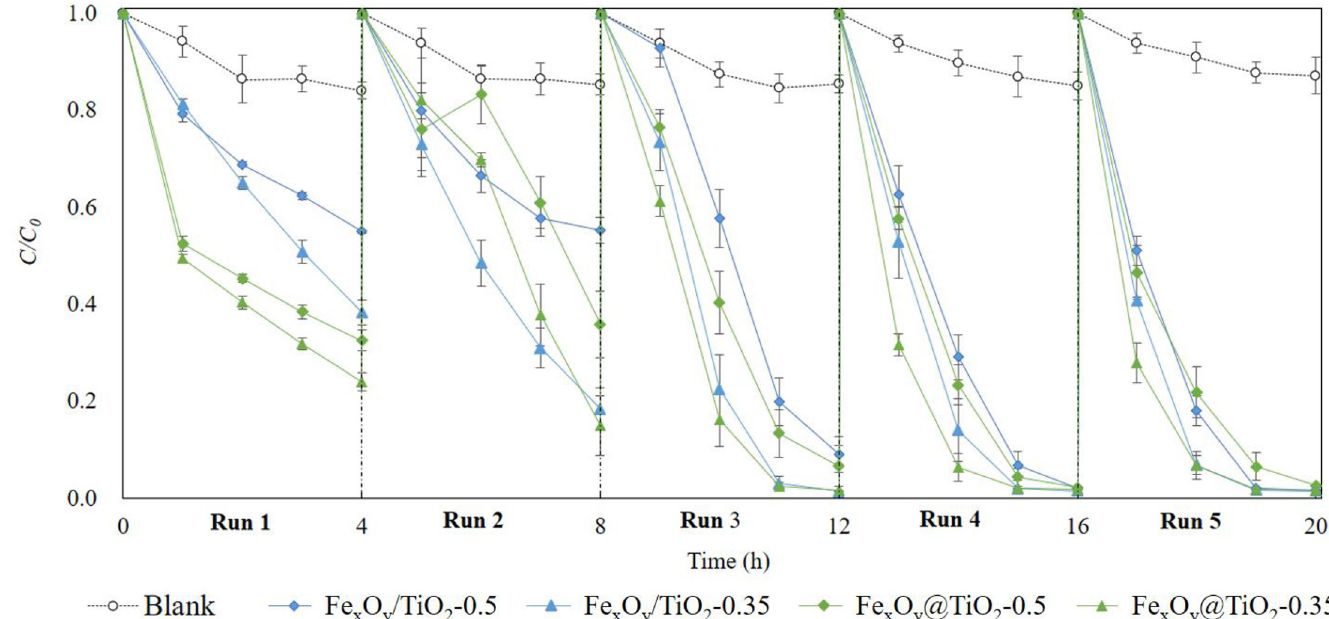
Fig 6. R6G degradation performance after reusing magnetic-TiO 2 -nanocomposites 5 times. Dotted lines represent R6G concentration dynamics in blank treatment without magnetic-TiO 2 -nanocomposites and solid lines represent R6G photodegradation dynamics under UV-irradiation with magnetic-TiO 2 -nanocomposites. Experimental conditions: UV-irradiation, 253 nm (20 W); initial magnetic TiO 2 nanocomposites concentration, 0.4 g/L; initial R6G concentration, 10 mg/L; pH, 7.0.